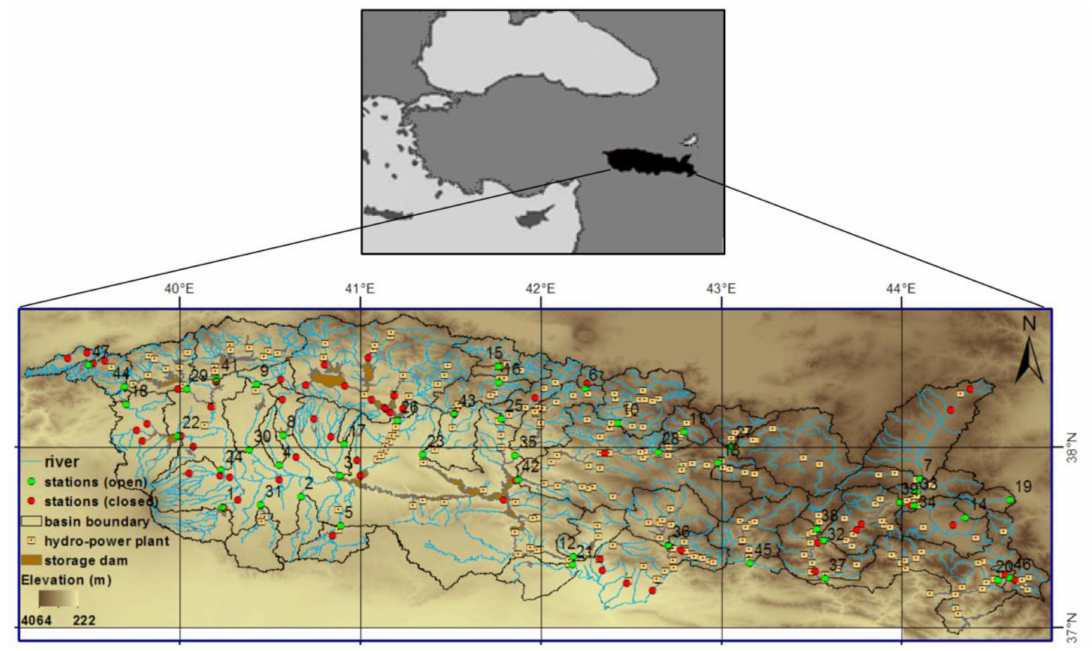
Figure 1. Study area, river, and distribution of hydropower plants, dams, and flow monitoring stations with sub-basin boundaries (red circles show closed stations, whereas green circles show open